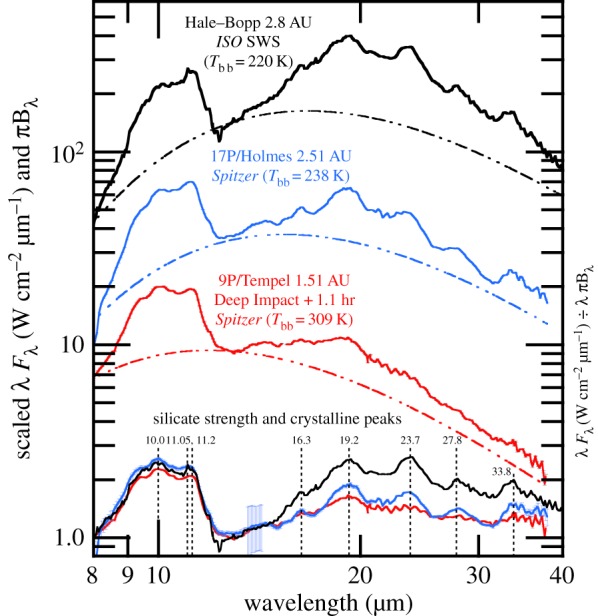
Three comets with high-contrast silicate features and with prominent forsterite (Fo100) resonant peaks designed by wavelength. Shown are the ISO SWS spectrum of Oort cloud Hale–Bopp [32,41,162,150], and the Spitzer IRS spectra of Jupiter Family comets 9P/Tempel 1 at +1 h post-Deep Impact [35] and the 17P/Holmes post-outburst [303] . (Online version in colour.)